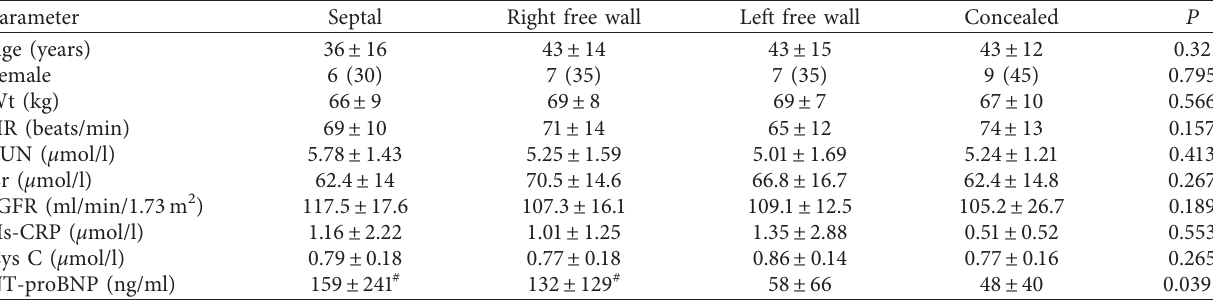
Table 1: Baseline characteristics of the study population.